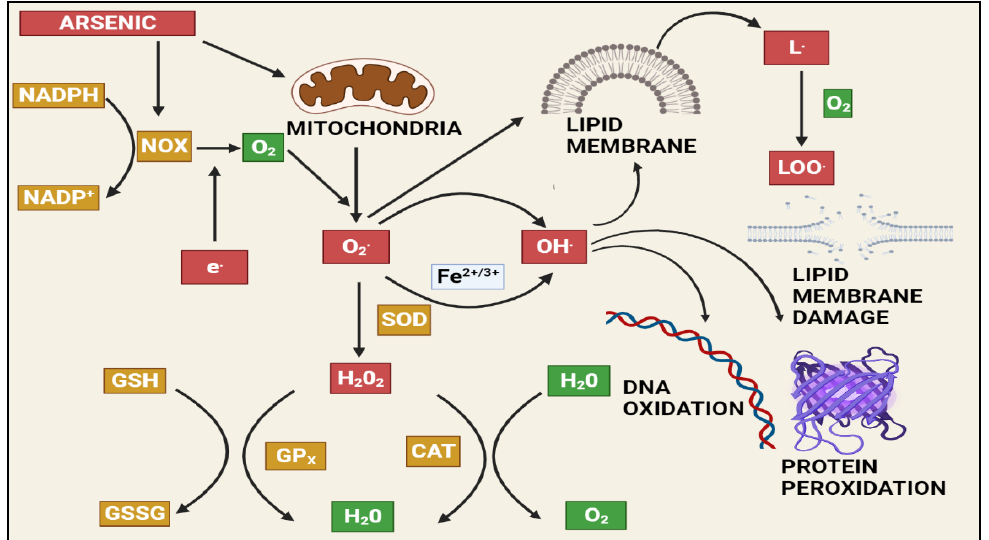
Figure 2. The effects of arsenic ‐ induced mitochondrial reactive oxygen species generation. Arsenic generates a significant amount of ROS, primarily through complexes I and II of the electron transport chain (ETC). The ETC produces superoxide radicals, which react with other radicals in the cell to form stable and long ‐ lived reactive species that damage macromolecules and induce apoptosis via various pathways. NAPDH: Nicotinamide adenine dinucleotide phosphate (NADP+), NADPH oxidase (NOX), GSH: Gluthathione, GSSG: Glutathione disulfide, GPx: Glutathione peroxidase, SOD: Superoxide dismutase, CAT: Catalase, H 2 O 2 : Hydrogen peroxide, LOO: lipid peroxy radical.